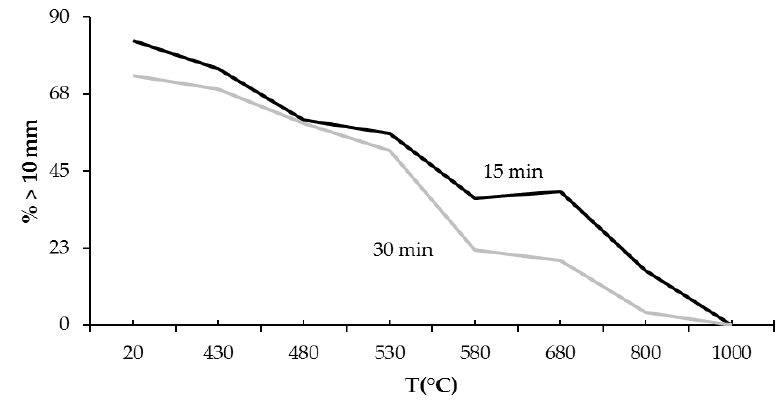
Figure 2. Degradation resistance loss as a function of temperature (Portland cement).